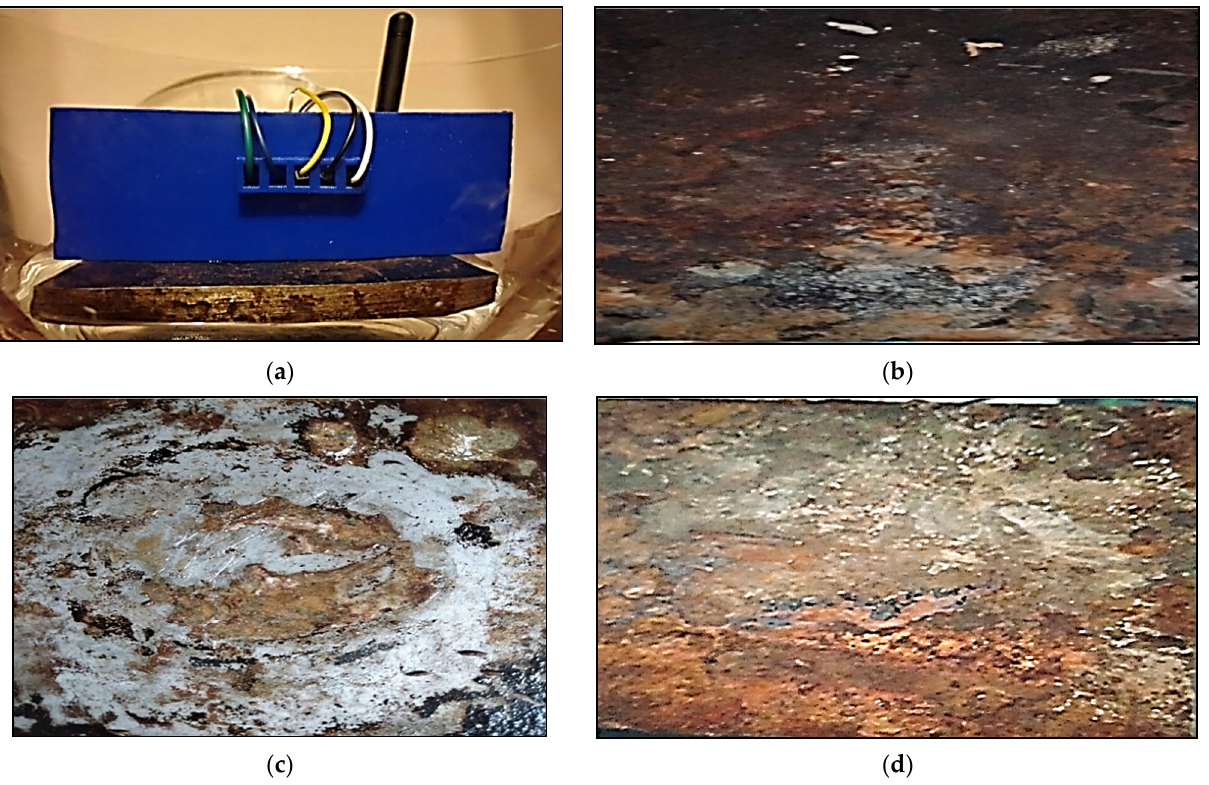
Figure 14. Experimental set up and corrosion in the steel plate at different stages: ( a ) experimental set up, ( b ) corrosion after 12 h, ( c ) corrosion after 24 h, and ( d ) corrosion after 72 h. At stages through the procedure, the corrosion products were cleaned for accelerat- ing the corrosion process. There was a measurement noise in the signals due to the elec- tronic components. A 10-point moving average filter was used to de-noise the signals. The results from the corrosion and AM 2302 sensors are shown in Figures 15 and 16, respec- tively.